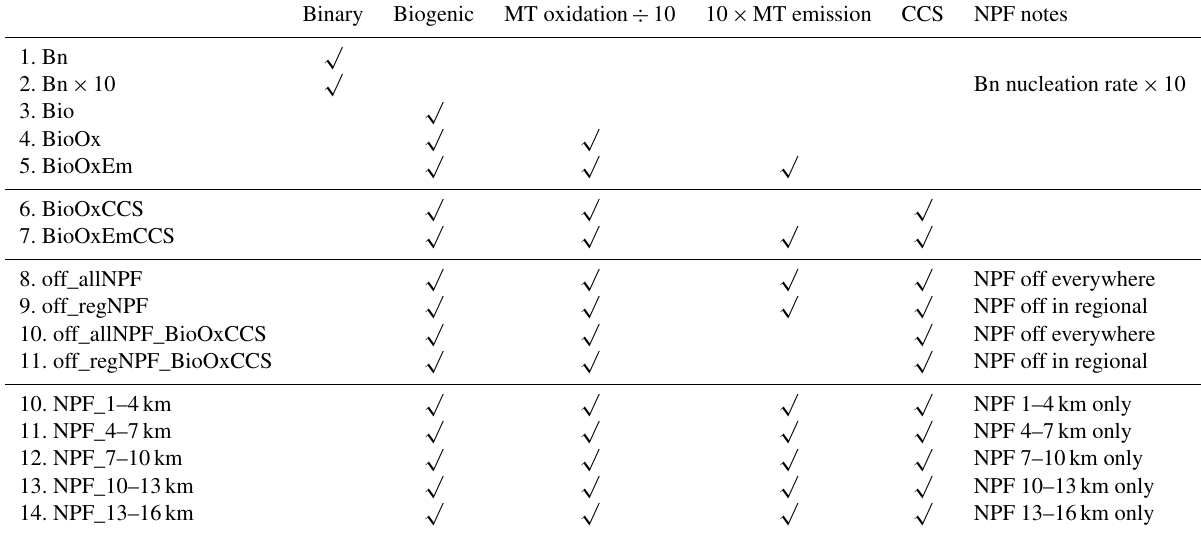
Table 2. All simulations and the NPF mechanisms. Monoterpene (MT) oxidation ÷ 10 denotes that the oxidation rates of monoterpenes (to secondary organics) are reduced by a factor of 10, and 10 × MT emission denotes increasing the monoterpene emission rate by a factor of 10. CCS represents the condensation sink from